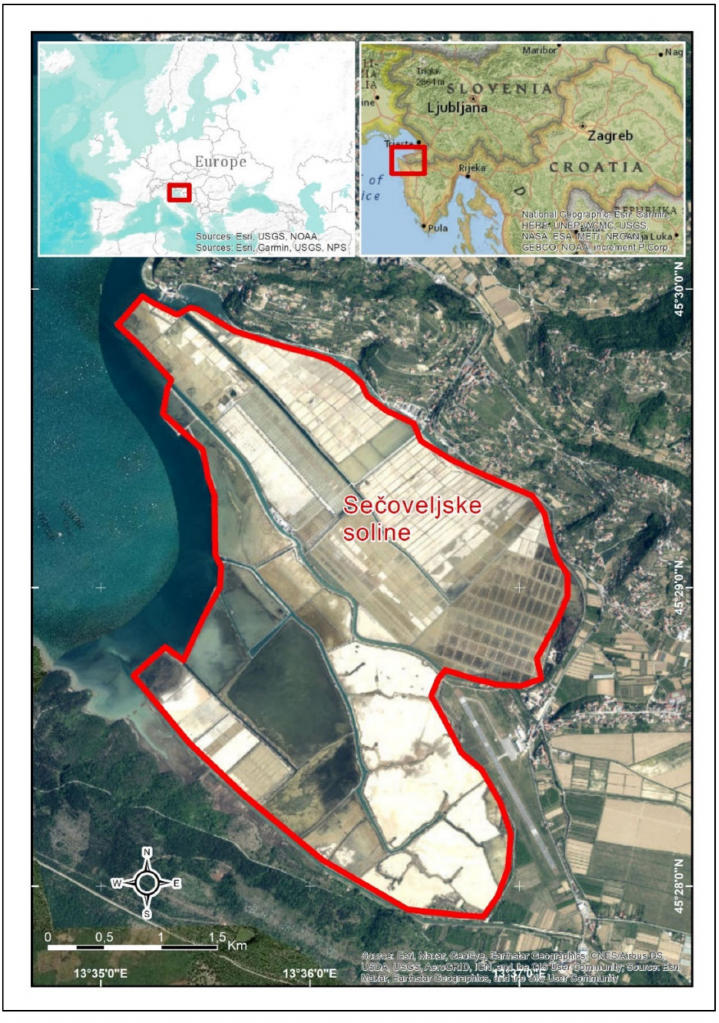
Figure 7. Maps of the study area and location of the Secovlje soline (Slovenia). The perimeter of the salina is delimited in red. Source: Own